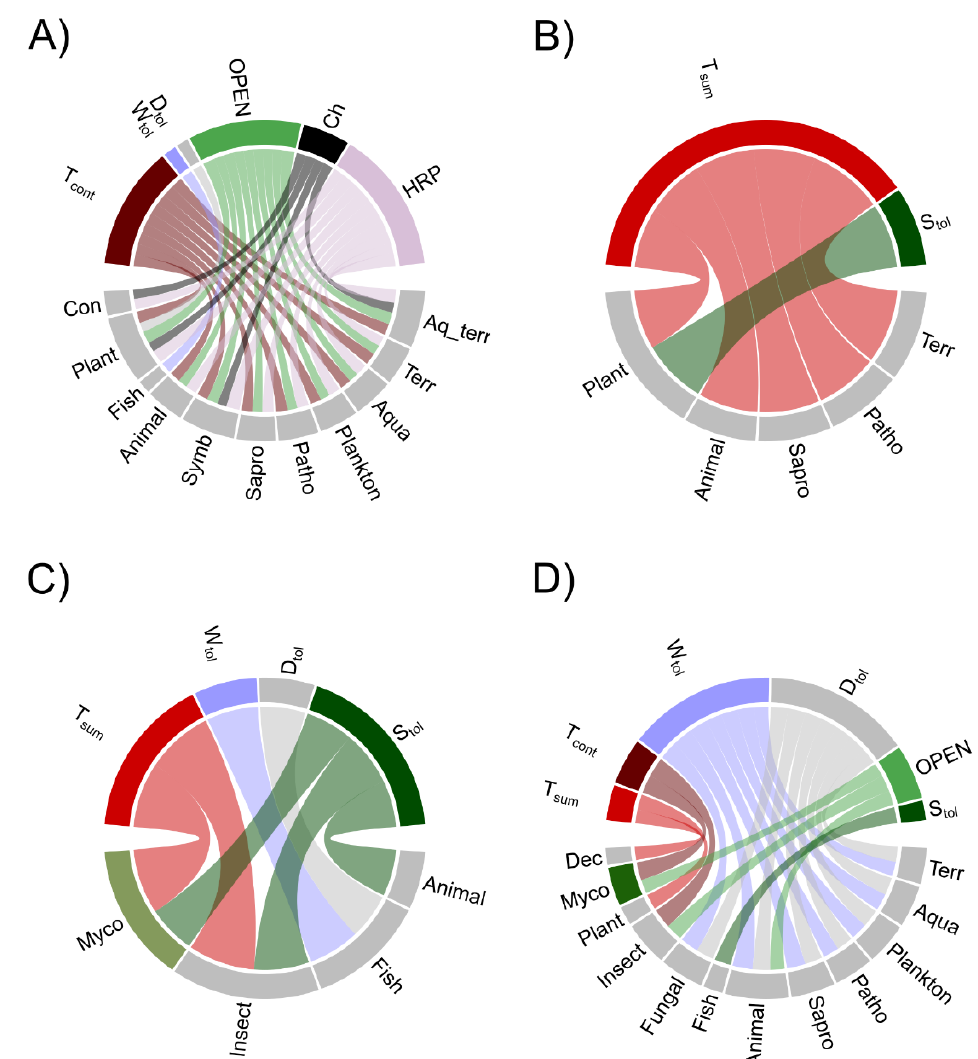
Figure 6. Associations between environmental paleoproxies and abundance in fungal ecophysiological groups over ~10.5 kyr. The two-way Pearson correlations are illustrated using Chord diagrams, where ( A ) shows strong positive correlations (r > 0.6) and ( B ) strong negative correlations (r < − 0.6) over the whole timespan (~10.5 kyr); ( C ) shows strong positive correlations (r > 0.6) and ( D ) strong negative correlations (r < − 0.6) over the period (2.0–10.5 kyr) excluding possible human impact (last ~2.0 kyr). Assigned abbreviations: water and terrestrial environment fungi (Aq_terr), terrestrial fungi (Terr), aquatic fungi (Aqua), pathotrophs (Patho), saprotrophs (Sapro), symbiotrophs (Symb), plankton parasites (Plankton), animal pathogens (Animal), fish pathogens (Fish), insect parasites (Insect), fungal parasites (Fungal), plant pathogens (Plant), mycorrhizal fungi (Myco), deciduous trees related fungi (Dec), conifers related fungi (Con).